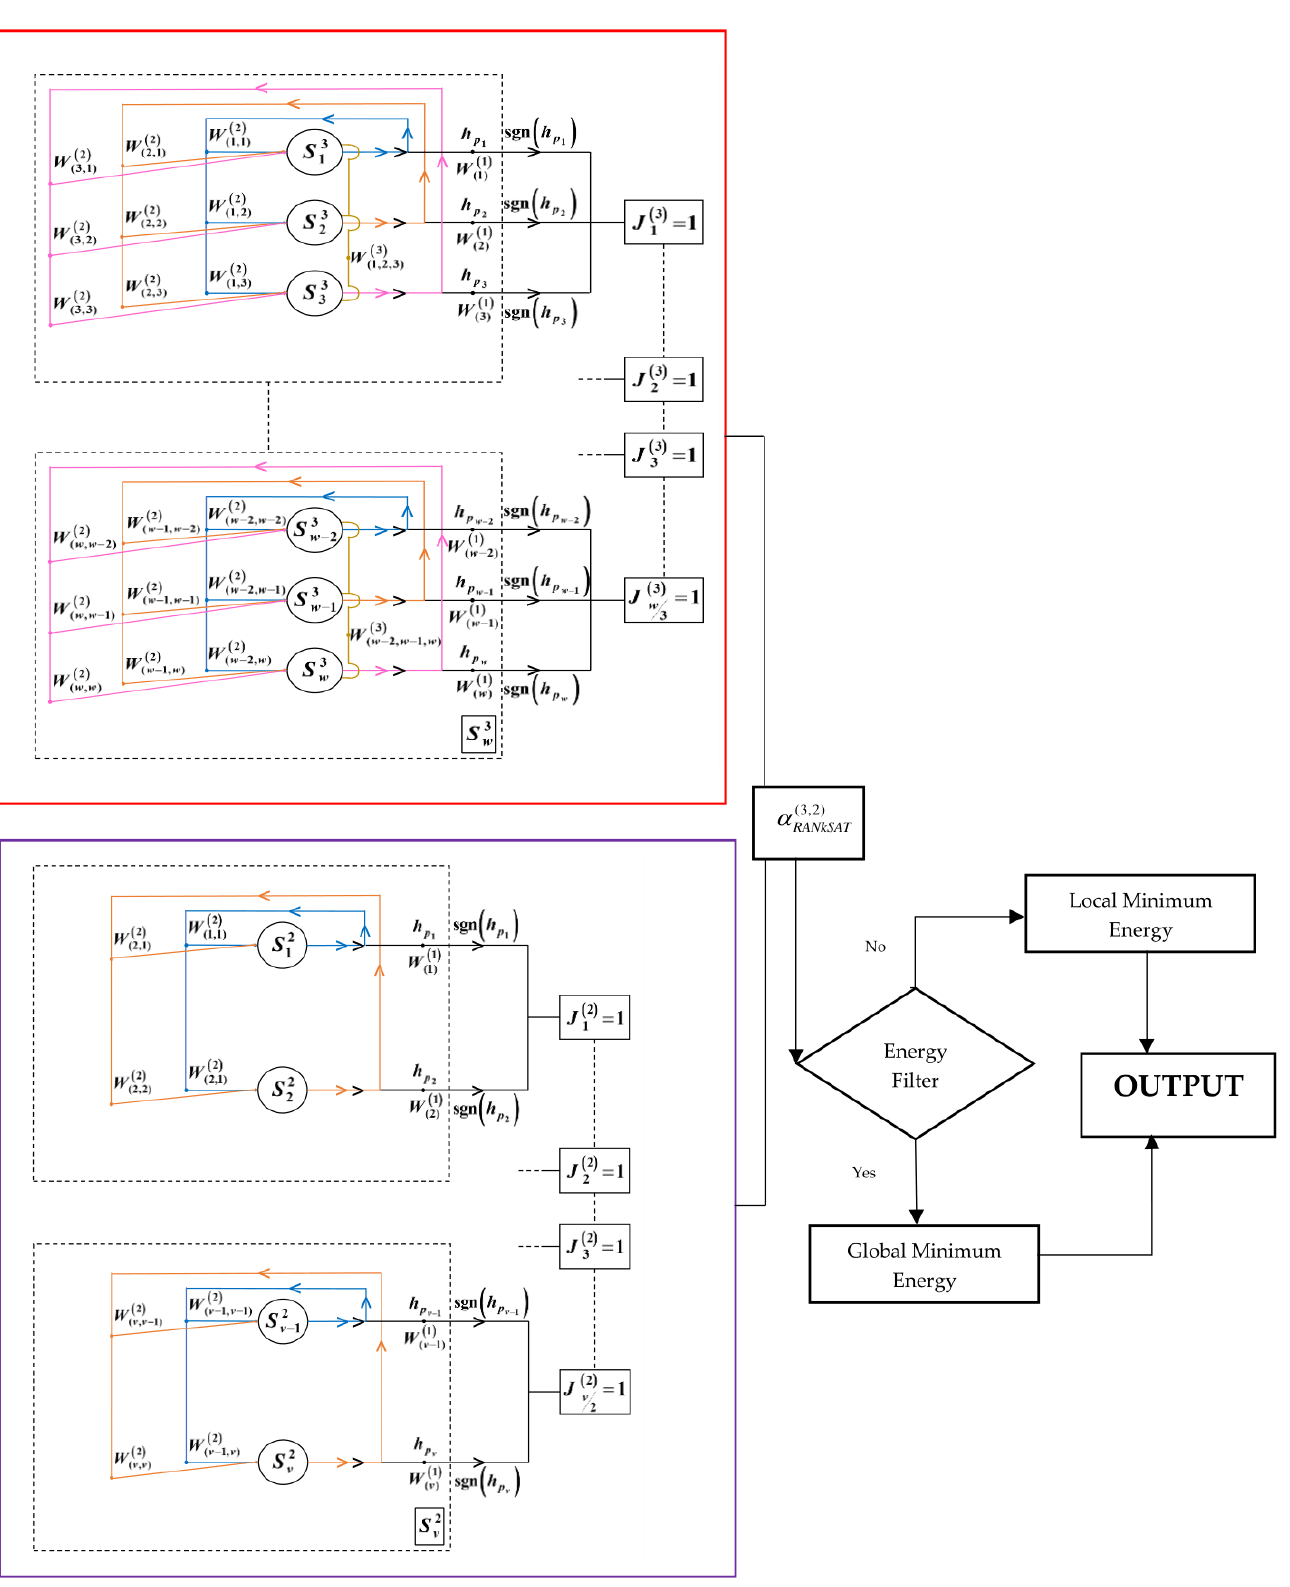
Figure 1. Schematic diagram for DHNN-RAN k SAT.